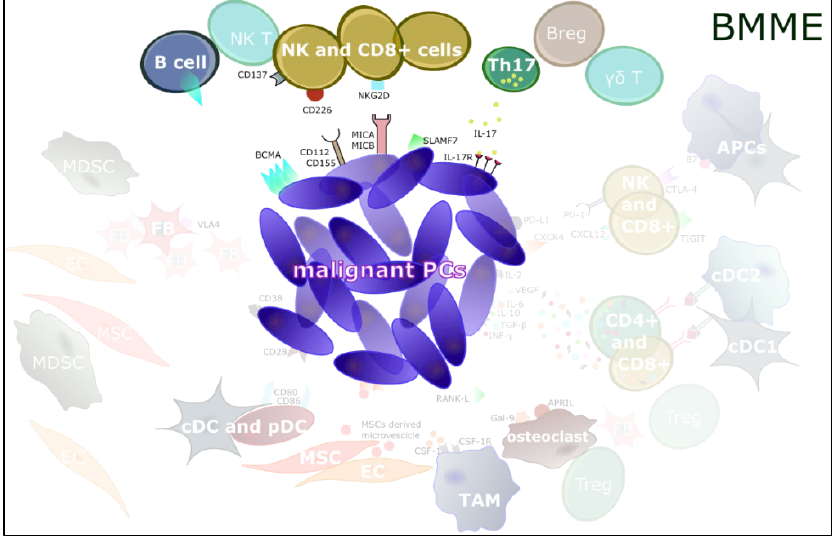
Figure 1. The bone marrow microenvironment (BMME) in multiple myeloma (MM). Complex interactions between non-hematopoietic stromal cells and BM immune system may support pro- and anti-tumor events in the BMME, highlighting the roles of immune components in the impaired anti-MM immune responses and disease progression. Innate and adaptive immune cells can recognize malignant plasma cells (PCs) and generate an anti-tumor immune response against tumors. A predominant role is attributed to immune cells, such as CD4 + Tregs and T cytotoxic CD8 + cells, which are considered effectors of host control for the MM PCs.